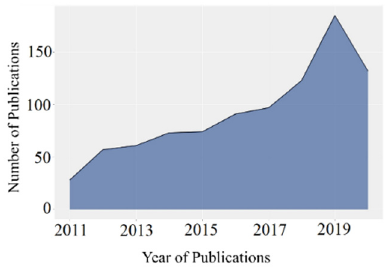
Figure 3. Annual Scientific Production.